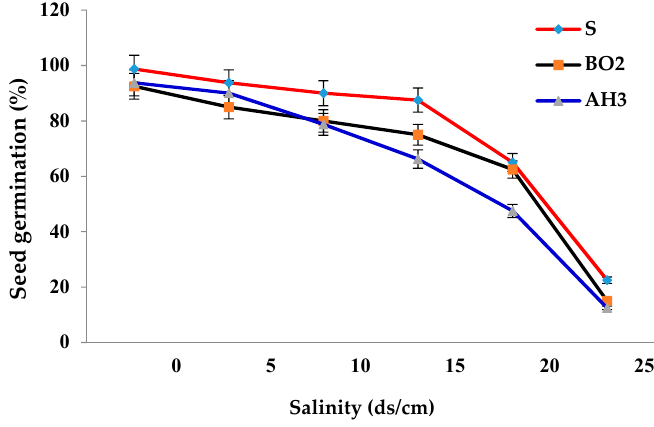
Figure 3. Final germination of the HF (S) (red bars), BO2 (Ile-1781-Leu) (black bars), and AH3 (Ile-2041-Asn) (blue bars) Lolium rigidum populations under water stress. The corresponding equations are: population S: y = 34.121 − 0.284 x , std. error: 6.398, ( r 2 = 0.77); population BO2 (Ile-1781-Leu): y = 32.543 − 0.293 x , std. error: 5.832, ( r 2 = 0.78); population R2 (Ile-2041-Asn): y = 31.308 + 0.290 x , std. error: 3.298, ( r 2 = 0.91).